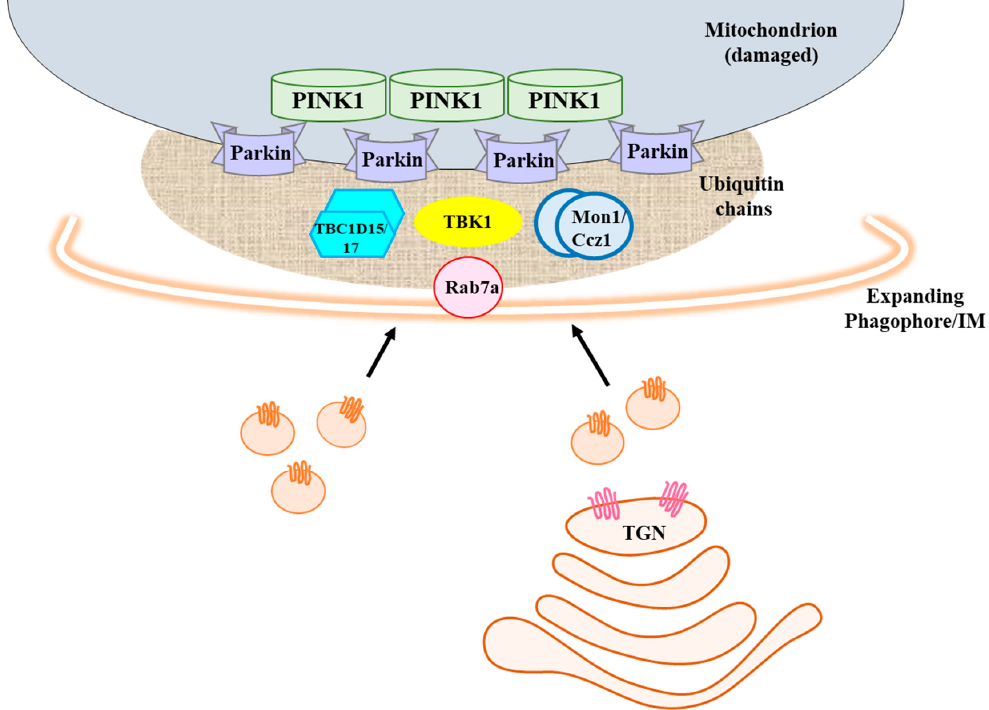
Figure 1. A schematic diagram depicting a role for Rab7a at the initial stage of mitophagy. Damaged mitochondria become coated with ubiquitin chains, proliferated on its outer membrane proteins by Parkin, which is recruited and activated by PINK1 stabilized on the mitochondrial surface. Rab7a is also recruited to damaged mitochondria, likely by its GEF Mon1 ‐ Ccz1. Rab7a’s activity at the mitochondria is dependent on proper cycling of its guanine nucleotide binding effected by its GEF and GAPs, like TBC1D15/17 and TBC1D5 (not shown here for brevity), and is also modulated by TBK1 phosphorylation. Rab7a at the damaged mitochondria facilitates the input of Atg9a containing membranes into the growing phagophore. See text for more details.